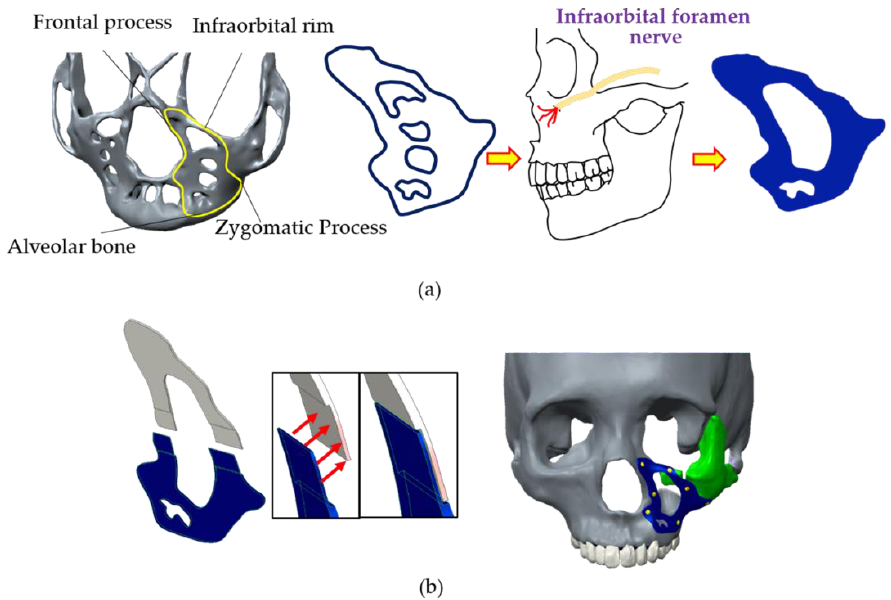
Figure 3. ( a ) The patient-specific repairing thin (PSRT) implant contour was generated along the frontal process, infraorbital rim, zygomatic process, alveolar bone, and back to the frontal process. The top three inner closed loops were integrated; ( b ) a thin implant was designed as the upper and lower halves by an embedded combination. Six screw holes were designed at the PSRT implant surrounding boundary and can be fixed on the anatomy thicker cortical rims.